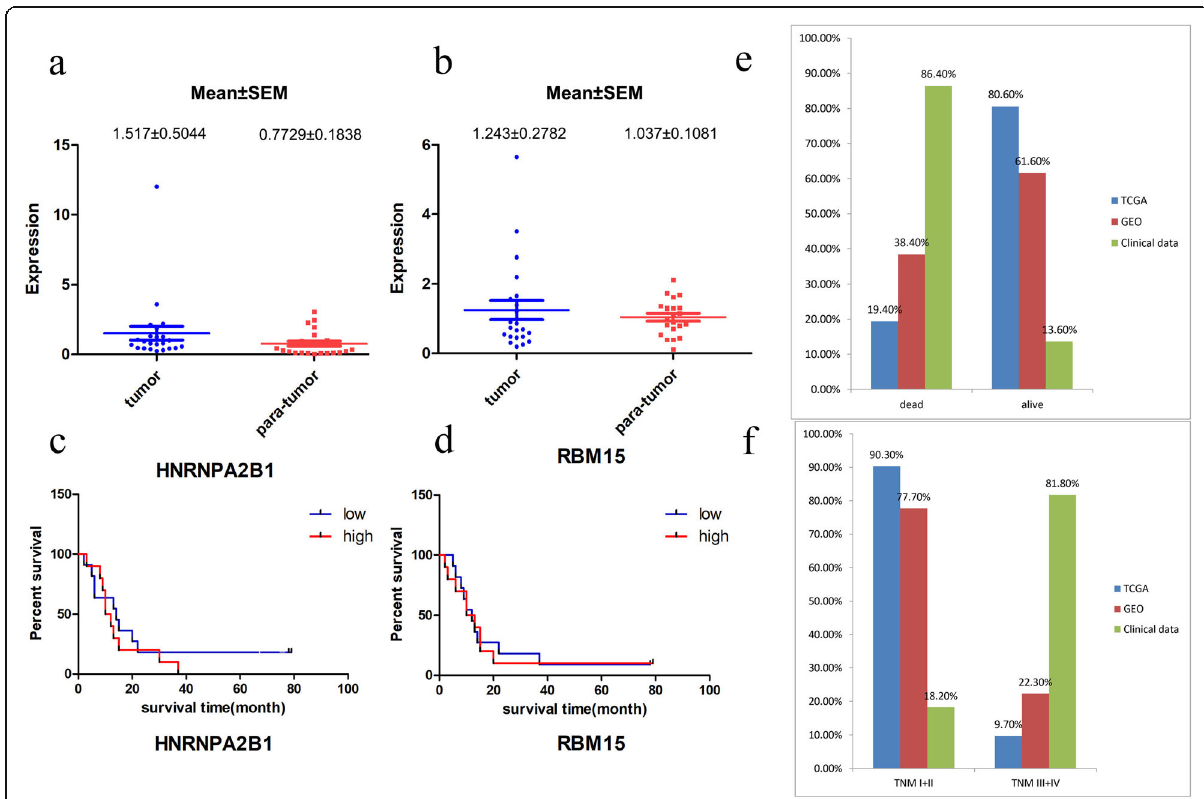
Fig. 3 HNRNPA2B1 and RBM15 mRNA expression measured by qRT-PCR; corresponding survival curves in the Guilin cohort. a The mRNA expression of HNRNPA2B1 in the tumor and para-tumor groups. b The mRNA expression of RBM15 in the tumor and para-tumor groups. c Survival curve of HNRNPA2B1 in the Guilin cohort. d Survival curve of RBM15 in the Guilin cohort. e Case distribution related to TNM stage (I + II vs III + IV) in the TCGA, GSE14520, and Guilin cohorts. f Case distribution related to survival state (dead vs. alive) in the TCGA, GSE14520, and Guilin